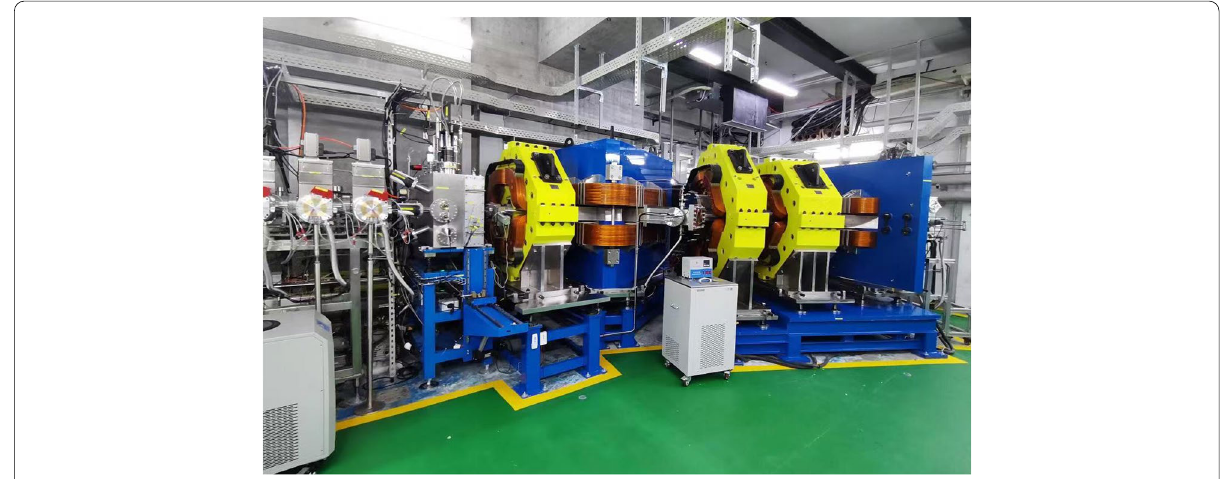
Fig. 6 Photo of the new gas-filled recoil separator,